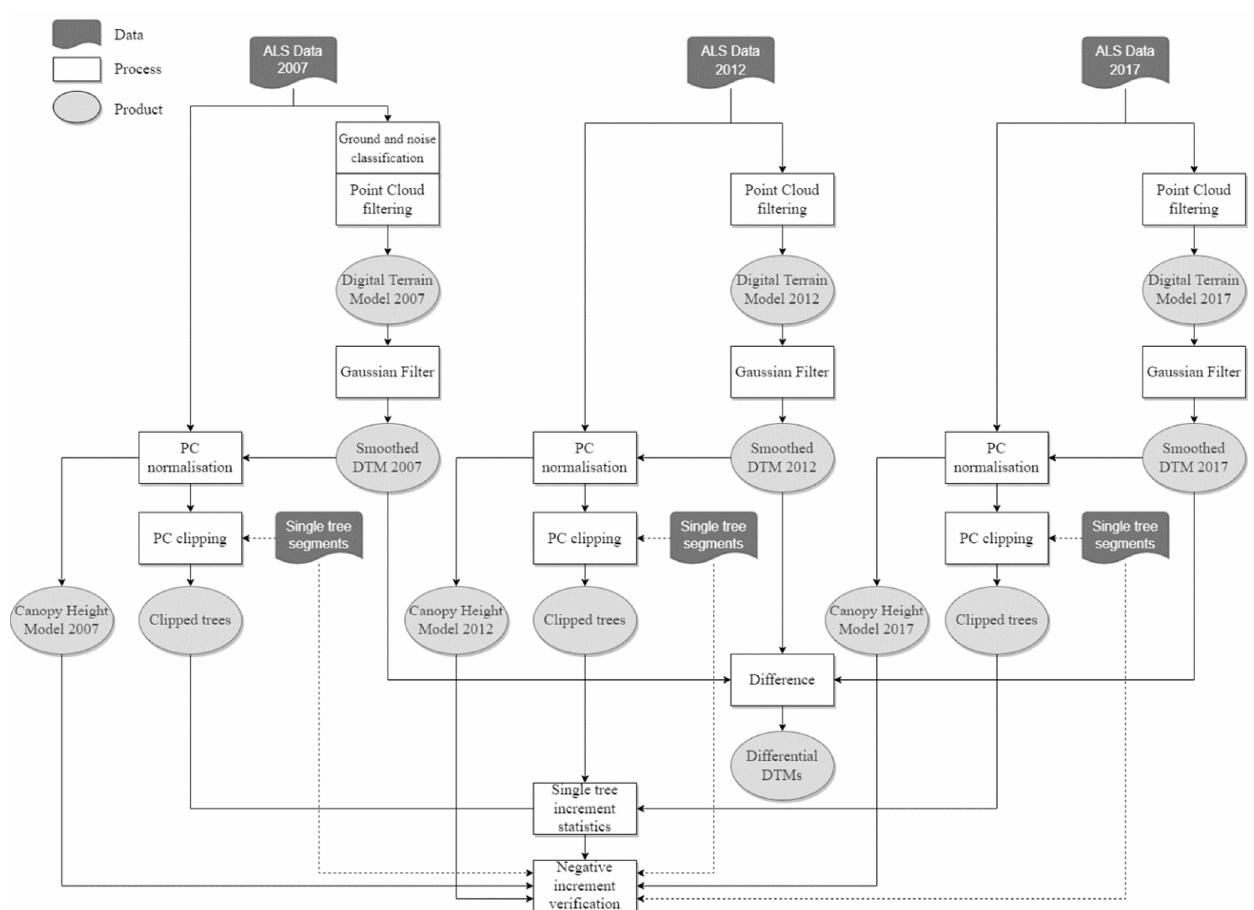
Figure 6. ALS data processing procedure for obtaining height measurements of individual Scots pine trees from each of the three scannings and verification of the tree height increment values.